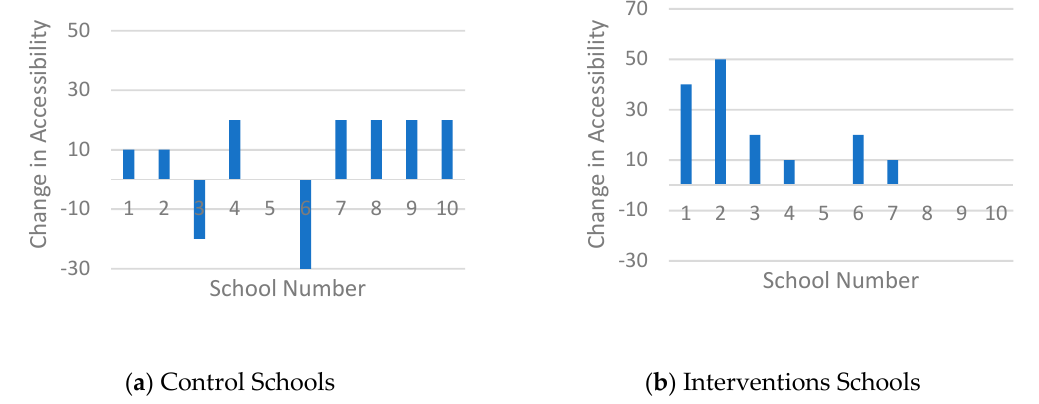
Figure 4. Histogram of the changes in fulfilled accessibility criteria.